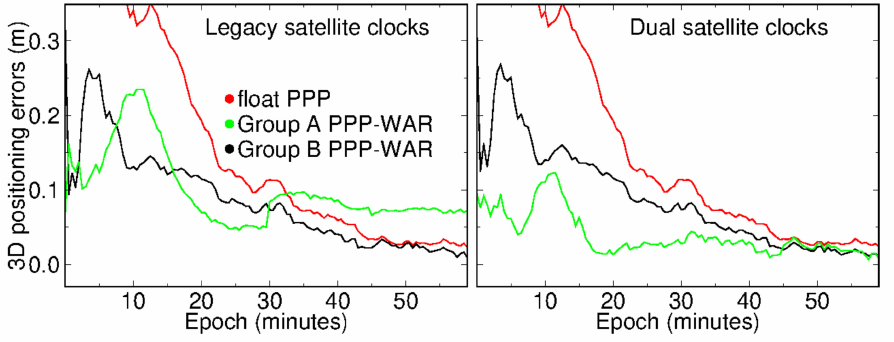
Figure 2. PPP-WAR solutions at station WTZZ at UTC 9:00 on day 183 of